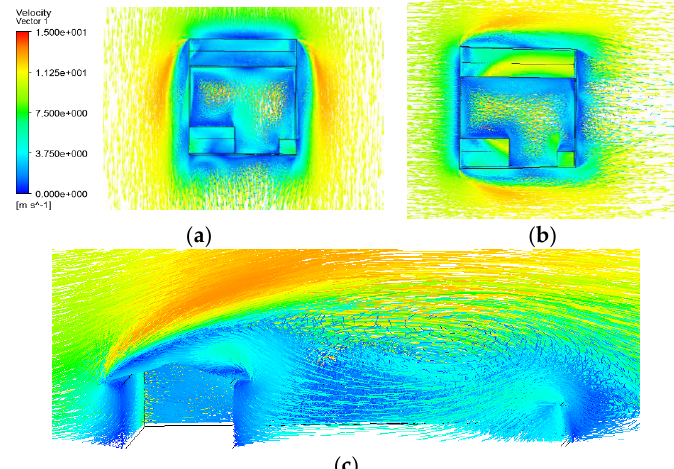
Figure 10. Wind velocity around the building: ( a ) north wind, ( b ) west wind, and ( c ) sectional view of velocity distribution in the north wind.